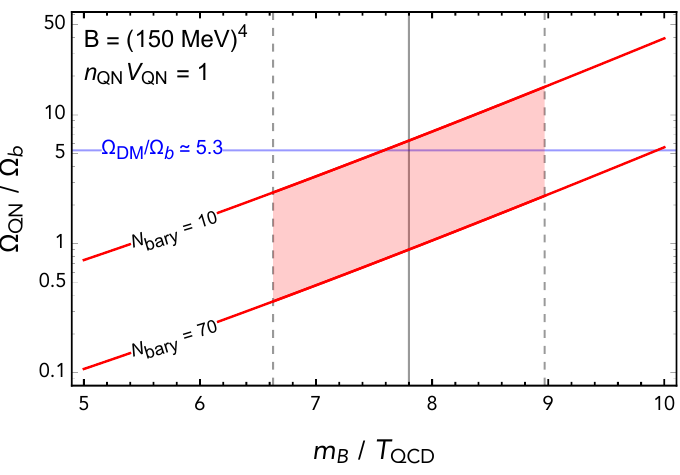
Figure 5 . The relic abundance of 6FQM nuggets as a function of the baryon mass m B and the QCD phase transition temperature T . In section 3.5 we estimate m B =T ’ 7 : 8, and we show QCD QCD the (cid:6) 15% error bands. We (cid:12)x the di(cid:11)erential vacuum pressure to be B ’ (150 MeV) 4 , which matches the usual QCD bag parameter. The number of light baryons in the hadronic phase at t QCD depends on the value of the Higgs condensate at that time; the value of N bary varies from 10 (top) to 70